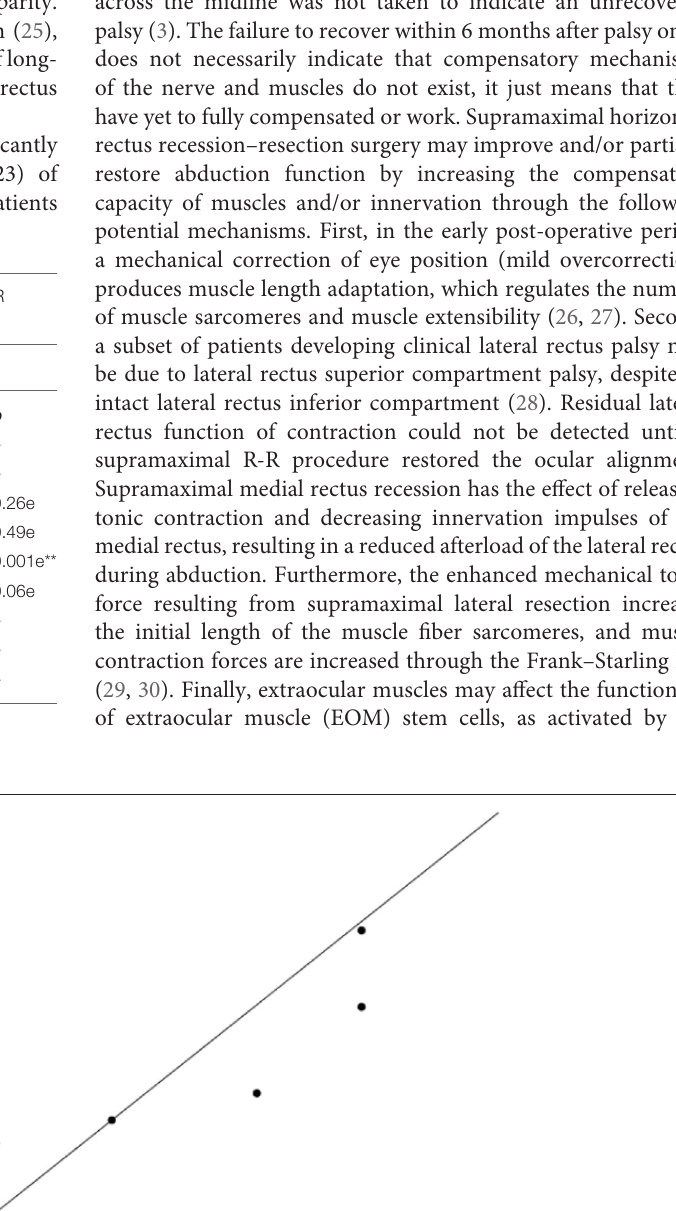
Frontiers in Medicine |